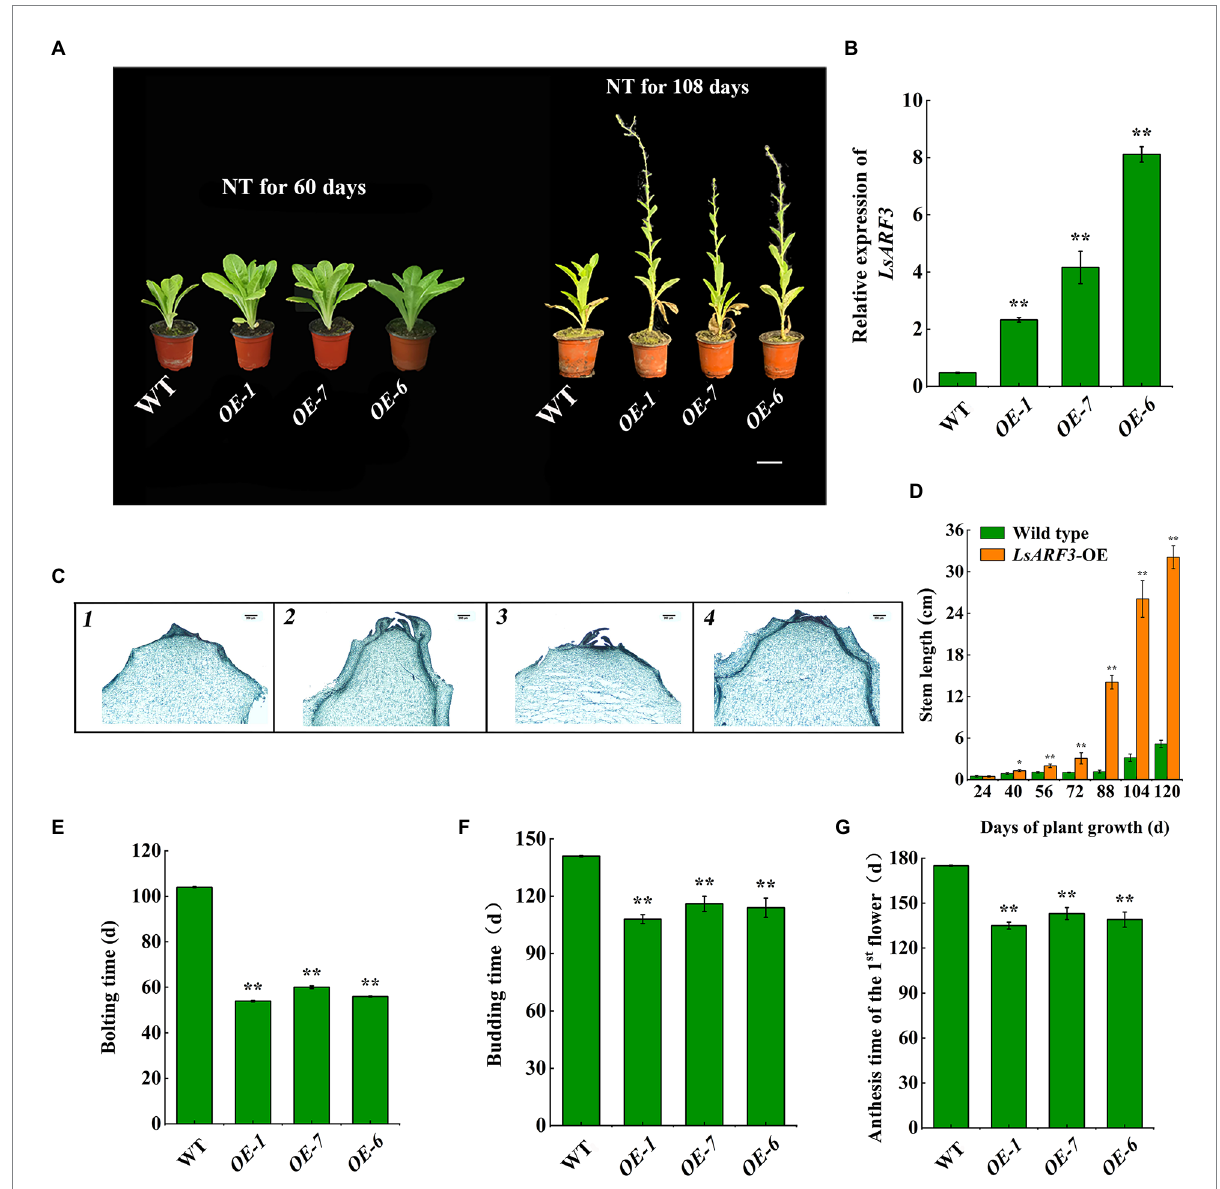
FIGURE 3 Overexpression of LsARF3 in lettuce. (A) Phenotypes of WT and LsARF3 -OE lines. Bar = 6 cm. NT represents normal temperature condition. (B) Expression level of LsARF3 in WT and LsARF3 -OE lines. (C) Flower bud differentiation of stem apex at 60 days during growing. 1.WT; 2. OE-1; OE-7; 3. OE-6. Bar =200 μ m. (D) Stem length change of WT and LsARF3 -OE lines. (E) Bolting time of WT and LsARF3 -OE lines. (F) The budding time of WT and LsARF3 -OE lines. (G) Anthesis time of the 1st flower of WT and LsARF3 -OE lines. Significant differences were tested by Student’s t -test (*indicates p < 0.05 and **indicates p <